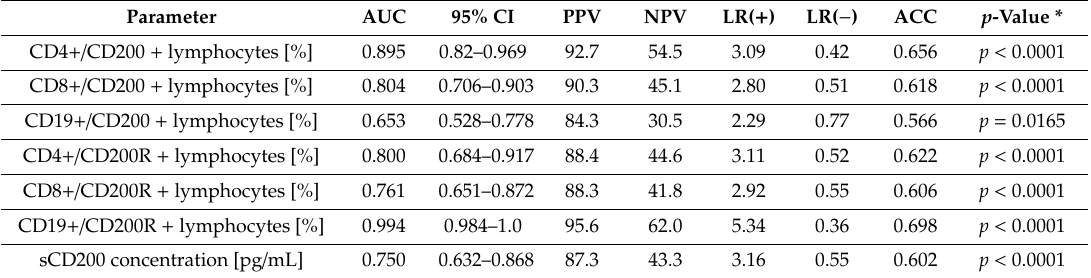
Table 8. Receiver operating characteristic (ROC) analysis to determine the diagnostic accuracy of immunological parameters in EMS patients.